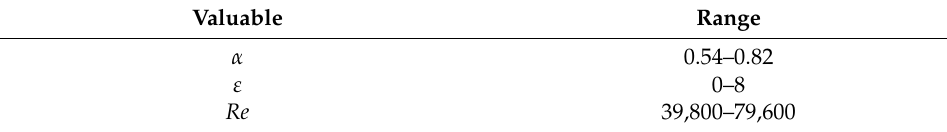
Figure 19. Flowchart for predicting the Nusselt number. Table 5. Ranges of the design